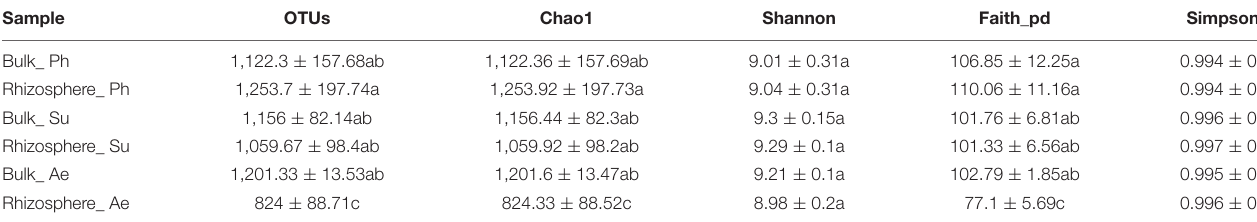
TABLE 1 | α -diversity in the rhizosphere and bulk soils of different halophytes.